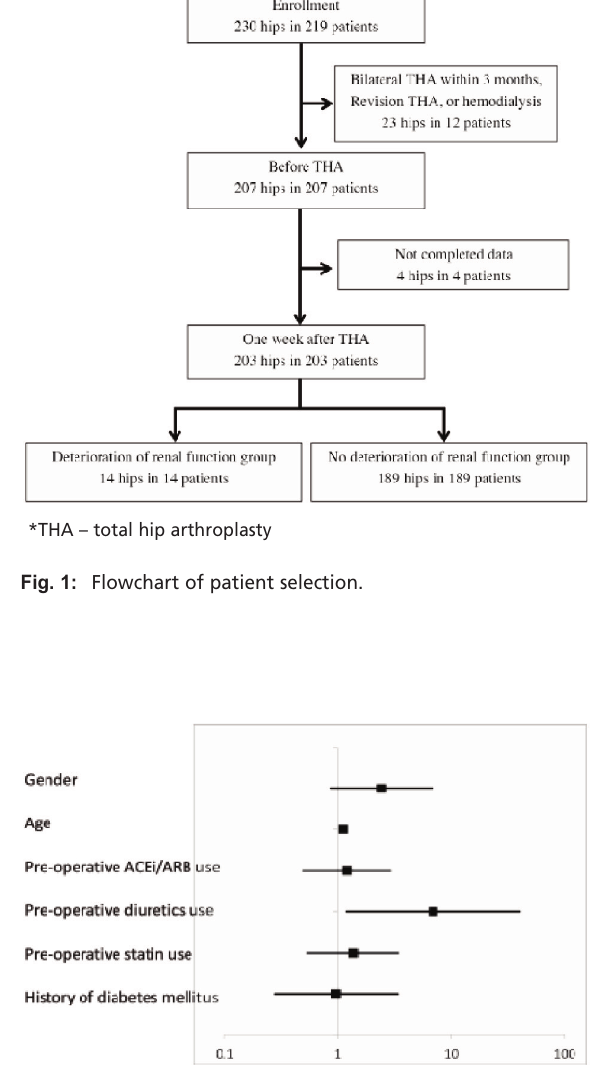
*THA, total hip arthroplasty; NSAIDs, nonsteroidal anti- inflammatory drugs; eGFR, estimated glemerular filtration 95% Confidence Interval of factors associated with Fig. 4: deterioration of renal function one week after THA.